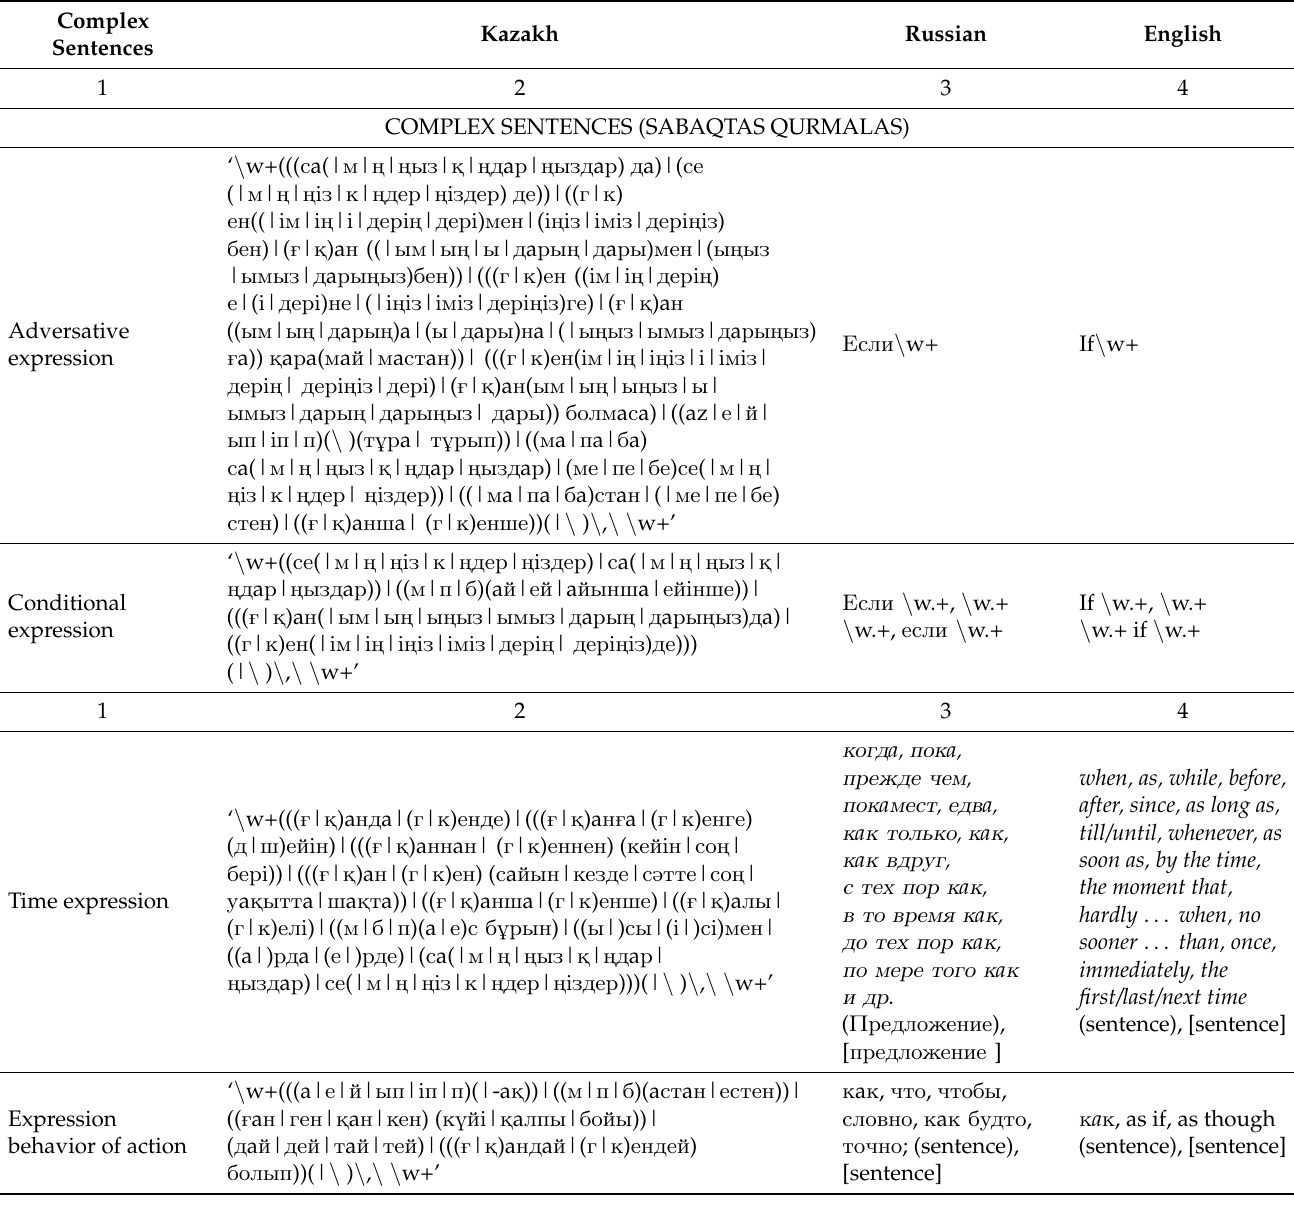
Table 2. Rules for complex